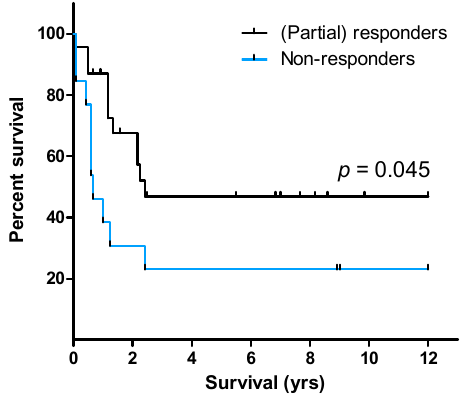
Figure 2. Patient survival dependent on response towards TLR agonists. Lack of response towards TLR1 / 2 targeting by Pam3CSK4 was significantly linked with poor outcome (log-rank test).